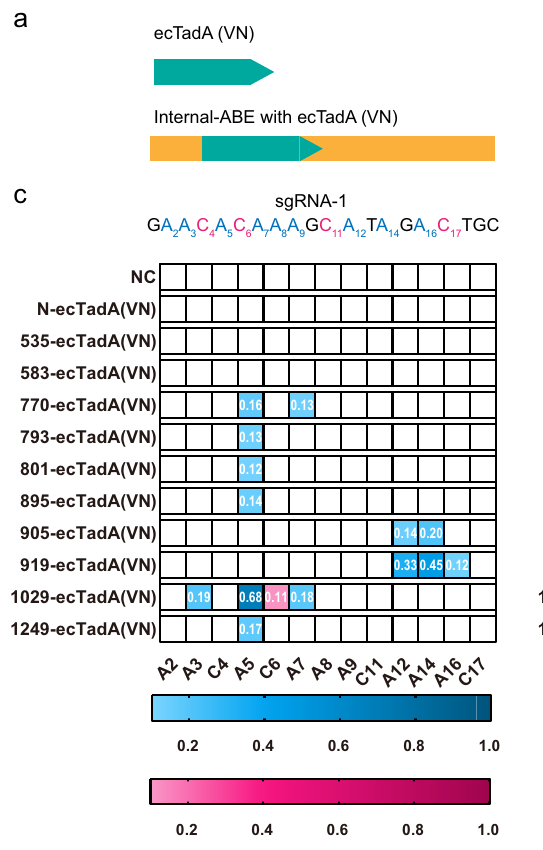
ecTadA(VN)) ( d ). Data shown here represent means of results from n =3 biologi- callyindependent experiments. NC negative control.VN, amino acid substitutions of A106V&D108N. Base editors generated by different fusion strategies were de fi ned as X-deaminase, with X representing fusion sites, such as N for N-terminal and 535 forinternalsites after the 535th aminoacid. Source data are providedas a Source Data fi